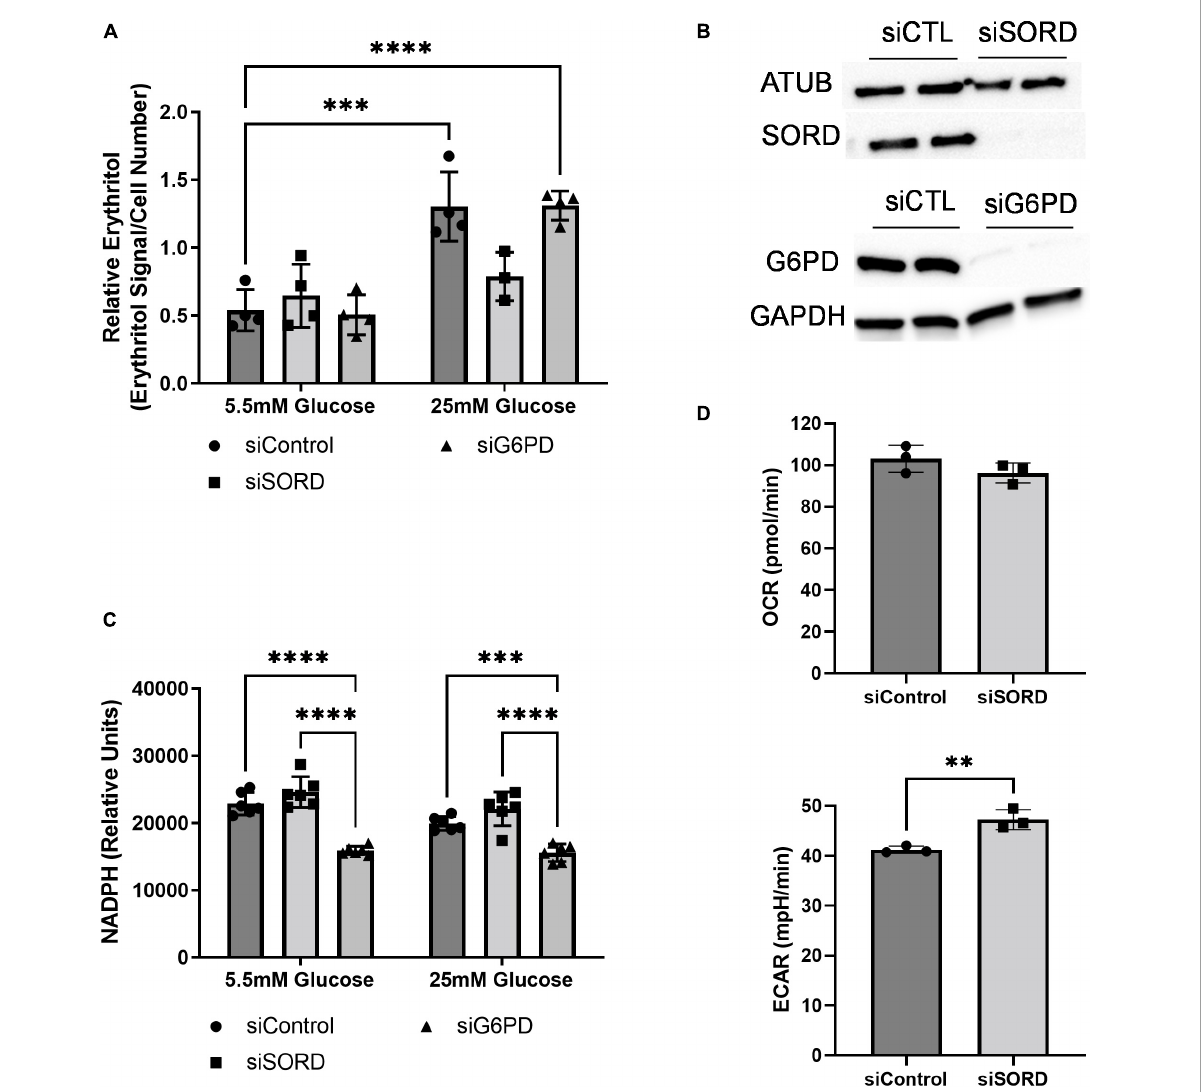
FIGURE3 SORD and G6PD knockdown affect cellular metabolism. Knockdown of SORD and G6PD were performed by reverse transfection. (A) Intracellular erythritol ( n = 4), (B) protein levels of SORD and G6PD, and (C) intracellular NADPH were measured after 48 h treatment with 5.5 or 25 mM glucose ( n = 6). Erythritol was normalized to internal standard and cell number. (D) OCR and ECAR were measured in control or SORD knockdown cells following 48 h in 10 mM glucose media and normalized to cell number ( n = 3). Data is presented as mean ± SD, (A,C) were analyzed by two-way ANOVA followed by Sidak’s multiple comparisons test, (D) was analyzed with an unpaired t -test. ∗∗ p < 0.01, ∗∗∗ p < 0.001, ∗∗∗∗ p < 0.0001. ATUB, alpha tubulin; ECAR, extracellular acidification rate; GAPDH, glyceraldehyde 3-phosphate dehydrogenase; G6PD, glucose 6-phoshate dehydrogenase; SORD, sorbitol